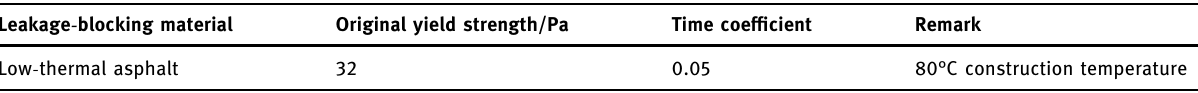
Table 6: Performance indicators of the low - thermal asphalt leakage - blocking material Leakage - blocking